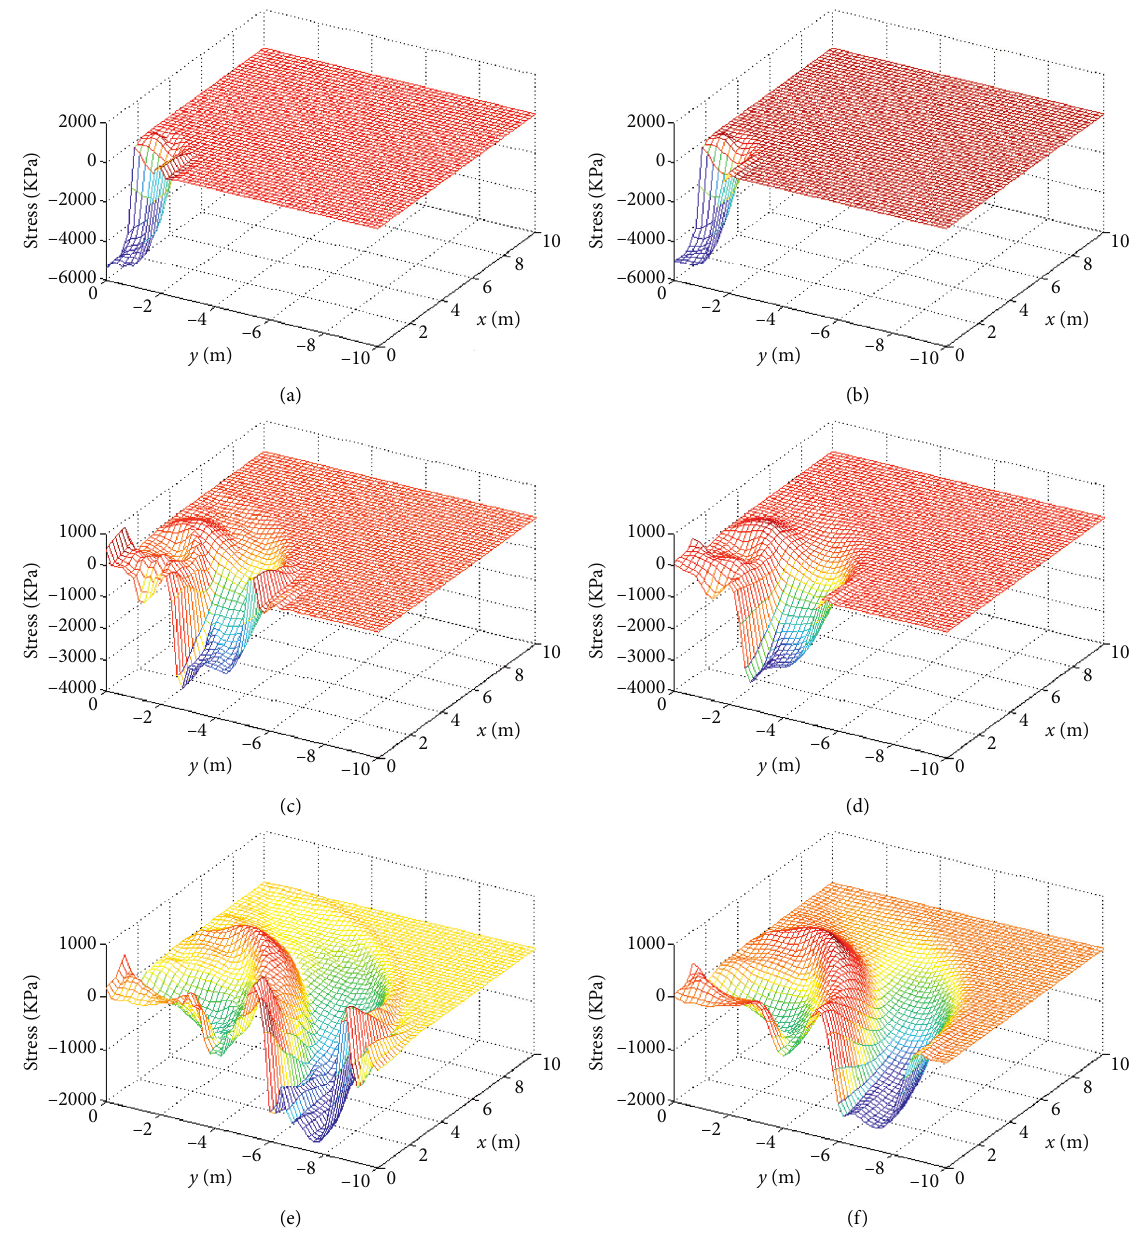
Figure 7: Comparison of the stress distributions between the Newmark method and the DGFEM. (a) Newmark method 0.001 s, (b) MDGFEM 0.001s, (c) Newmark method 0.003s, (d) MDGFEM 0.003s, (e) Newmark method 0.005s, and (f) MDGFEM Figures 7 and 8 illustrate the numerical results for the mean stress distributions and the pore fluid pressure with the coal at time t =0.001s, 0.003s, and 0.005s, as obtained by the